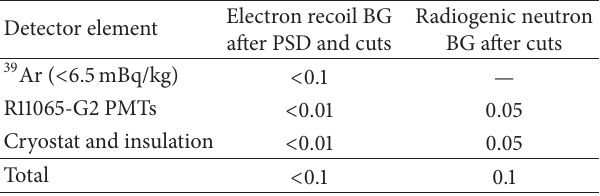
Table 1: A summary of the expected nuclear and electron recoil backgrounds depositing 55–240 keV 𝑟 in an 18-ton-year exposure of DarkSide-G2. We assume 39 Ar at our recently measured limit [25]. For PMTs, we use the expected background in the R11065-G2s based on measurements reported by Hamamatsu and our ongoing R&D. For the cryostat, we use detailed measurements of the steel used for the DarkSide-50 cryostat. After cuts include fiducial, energy, and multihit